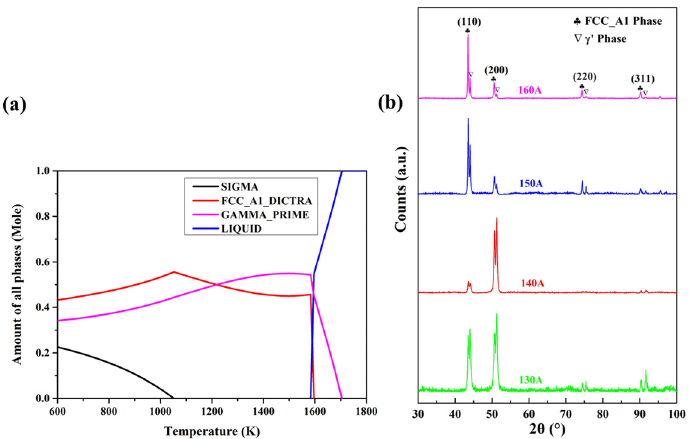
Figure 2. Simulation of the phase compositions of the CuNiCoCr alloy by CALPHAD ( a ) and XRD patterns of the Cu35Ni25Co25Cr15 HEA coatings deposited under different welding currents ( b ).